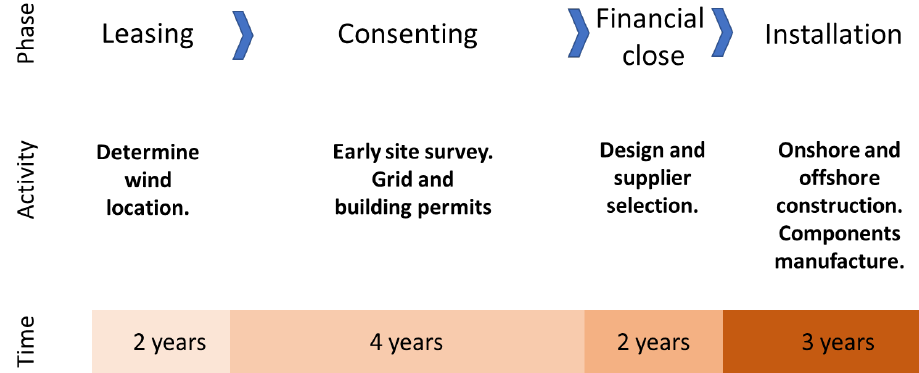
Figure 3. Floating farm development schedule. Adapted from [32].